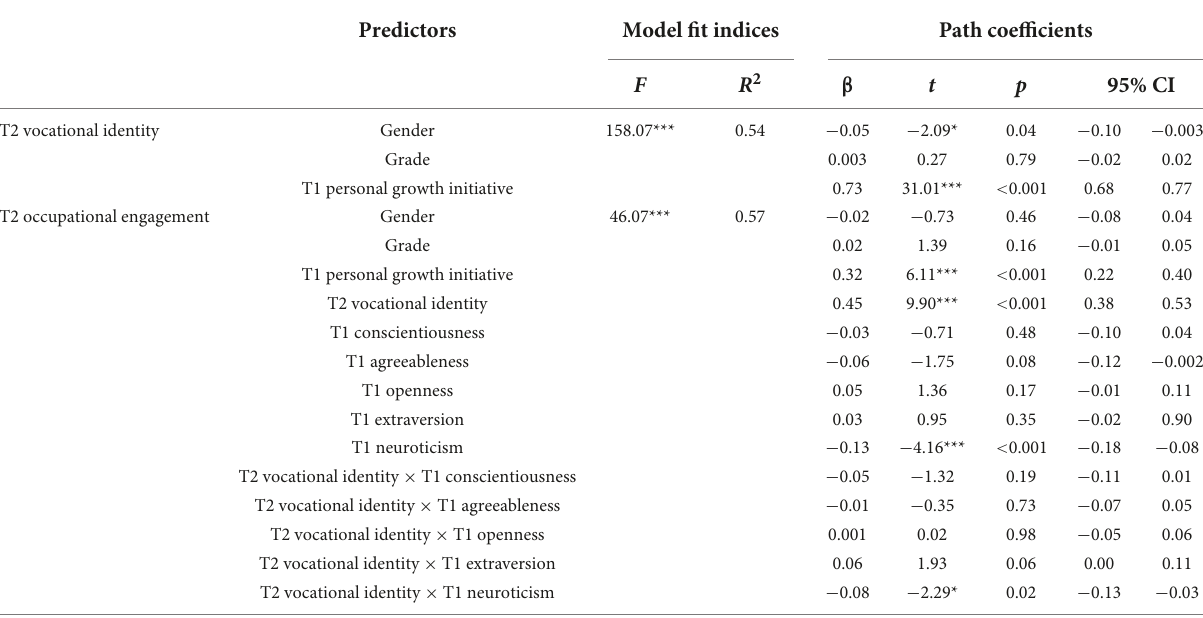
TABLE 2 Path analysis of the moderated mediation model. Predictors Model fit